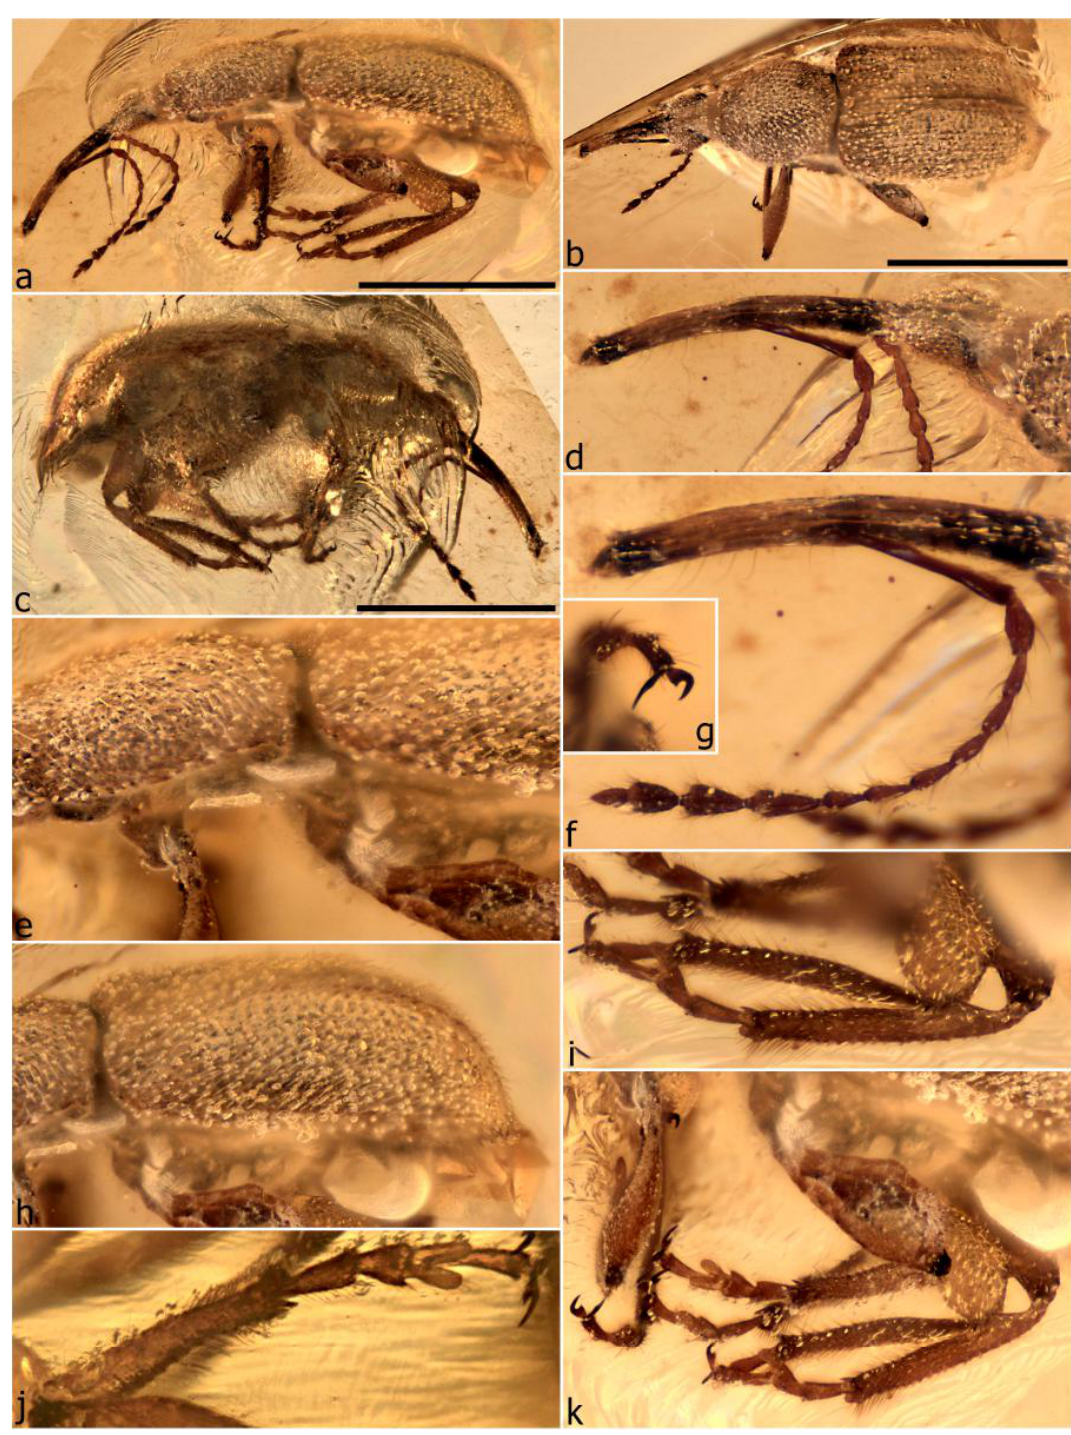
Figure 78. Habropezus tenuicornis sp. n., holotype. Habitus, left lateral ( a ); habitus, dorsal ( b ); habitus, right lateral, showing fracture plan obscuring right side ( c ); head ( d ); prothorax and humeral region of elytra ( e ); rostrum and antenna ( f ); left protarsal claw ( g ); elytra, left lateral ( h ); metatibiae ( i ); tibia and tarsus, ventral ( j ); legs ( k ). Scale bars: 1.0 mm (a–c). Material examined. Holotype (NIGP157021), male: well preserved, intact but poorly visible specimen, not distorted or compressed but body nearly entirely covered by thin cloudy whitish substance and tiny bubbles, right side of prothorax and elytra concealed by fracture and flow band, head, rostrum and appendages well visible; in irregular triangular prismoid (with sixth face) 7.5 × 5.1 × 3.0 mm; amber clear yellow, without debris, other fractures or bubbles.